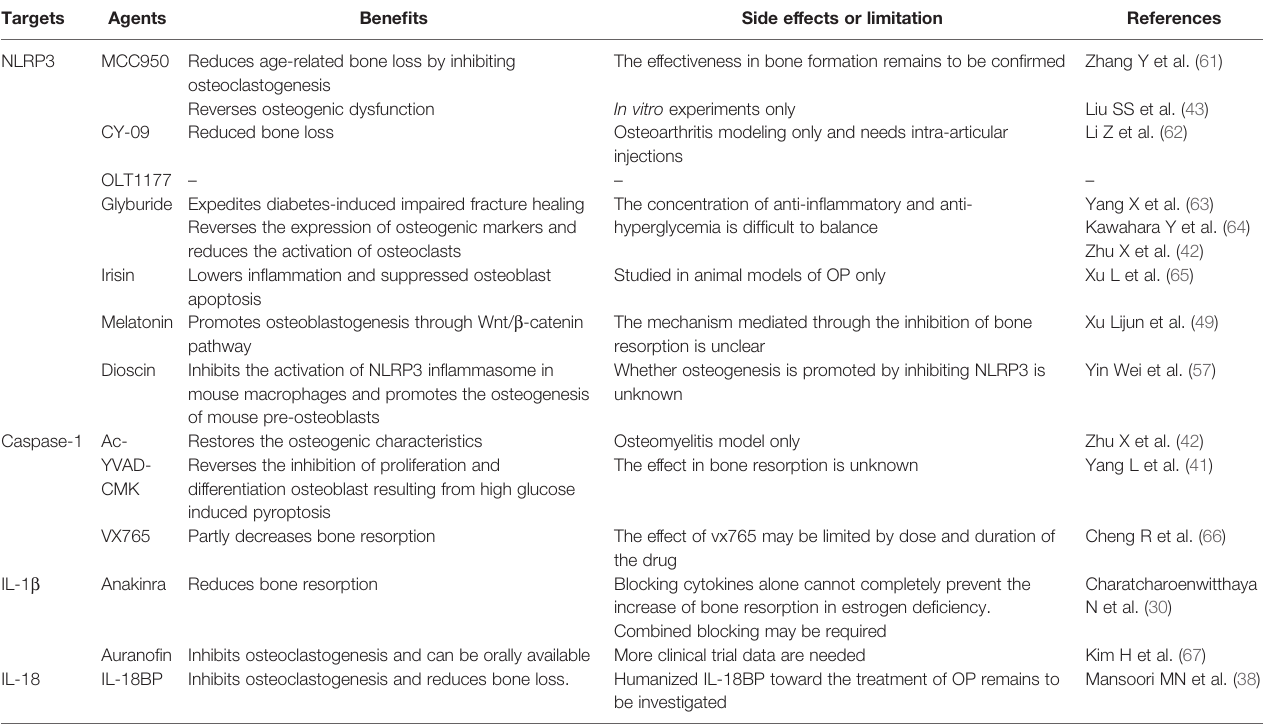
TABLE 2 | Inhibitors of NLRP3 in fl ammasome related to